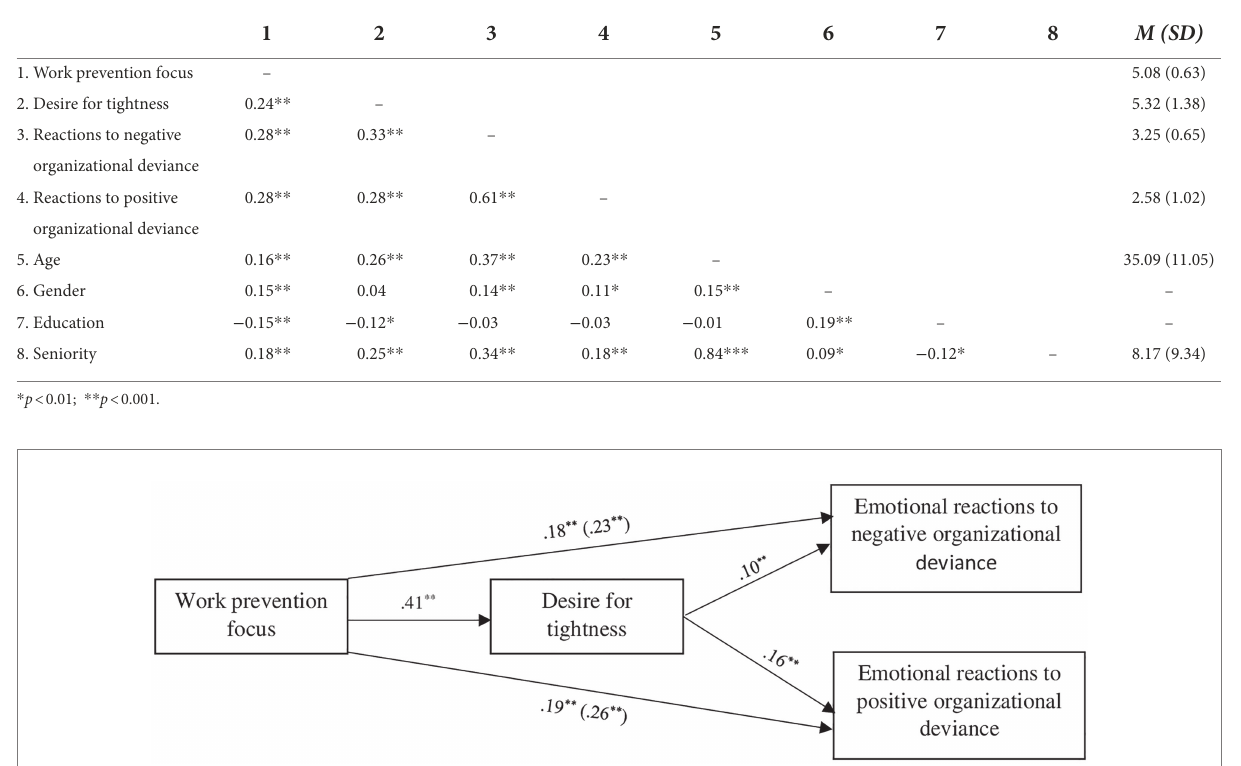
TABLE 1 Descriptive statistics and correlations between variables.